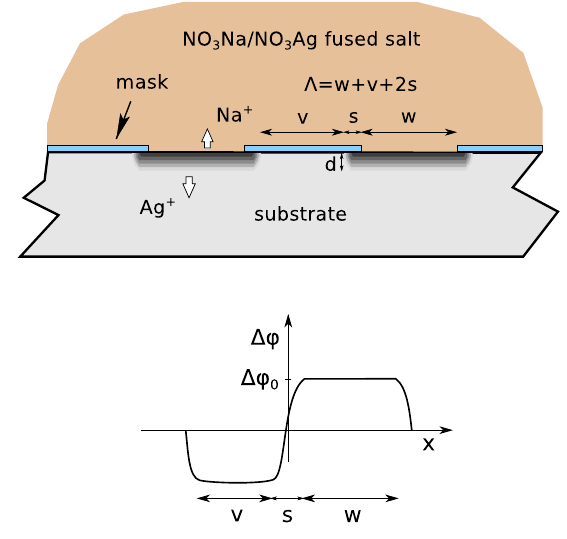
Figure 1. Scheme of an ion-exchanged grating and its phase pro fi le. The side di ff usion gives rise to a gradient in the phase pro fi